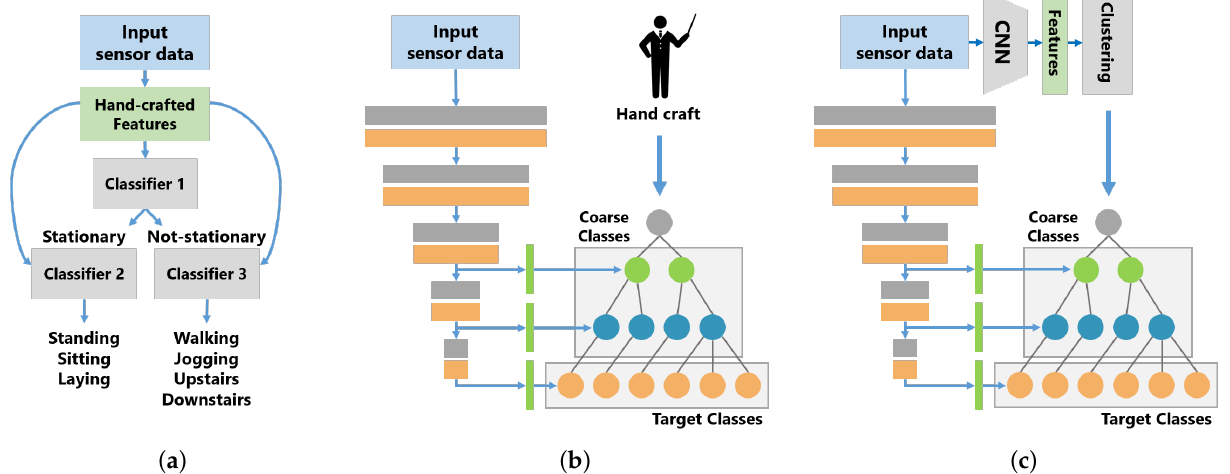
Figure 1. Model overview of the related methods ( a , b ) and of our method ( c ). ( a ) Hierarchical Classification. ( b ) B-CNN [7]. ( c ) Class Hierarchy Adaptive